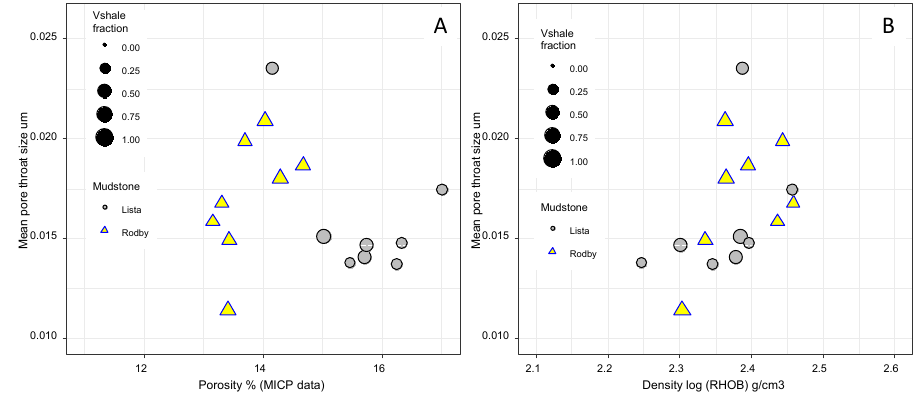
Figure 15. Mercury intrusion porosimetry (MICP) data linked to wireline log data. Diagrams prepared using R-studio-ggplot2 software [15]. ( A ) Comparison of porosity and mean pore throat size, from MICP analyses, subdivided by Vshale for the Rodby and Lista Shales, represented by the sizes of the symbols. The Lista Shales tend to have a slightly higher porosity than the Rodby Shale, but they tend to have broadly similar mean pore throat diameters. Lower Vshale seems to equate to slightly higher porosity but has no relationship to mean pore throat size. ( B ) Comparison of density log porosity (RHOB) and mean pore throat size, from MICP analyses, subdivided by Vshale for the Rodby and Lista Shales, represented by the sizes of the symbols. There seems to be positive relationship between bulk density and pore throat size with no simple di ff erences between the Rodby and Lista